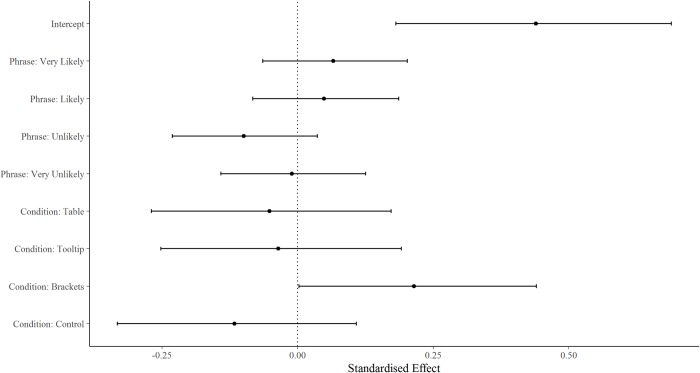
Hierarchical model output showing standardised effects of intercept, condition and verbal probability phrase.Dots represent the mean, bars represent 95% credible intervals. The vertical line at zero reflects the average level of consistency with the ICD 203 guidelines. Condition and phrase judgements above the line perform better than average, and those below the line performs worse than average.